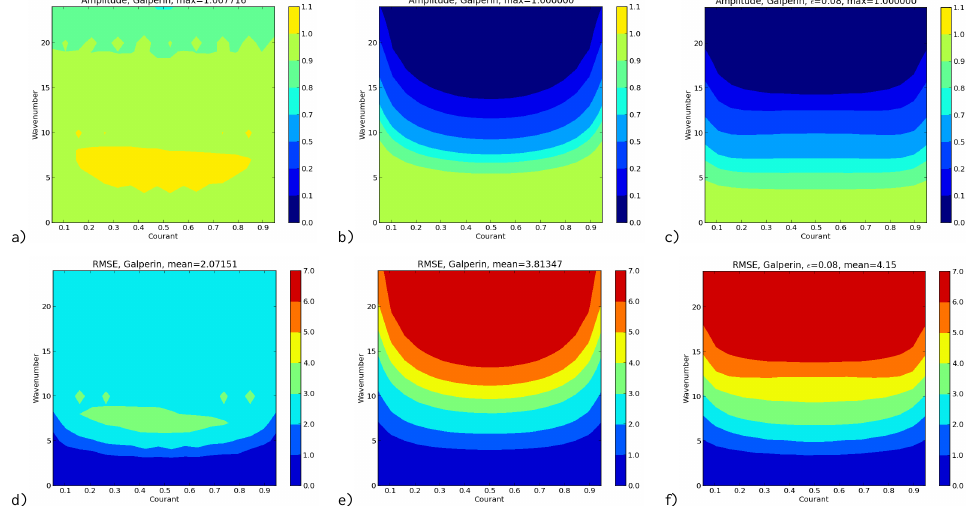
Figure 3. Spectral analysis for 1-D. Panels (a) and (d) : amplification factor (AF) and RMSE, respectively, for the Galperin scheme without a smoother; (b) , (e) : AF and RMS for the Galperin scheme with a large background; (c) , (f) : AF and RMSE for the Galperin scheme with smoother ε =